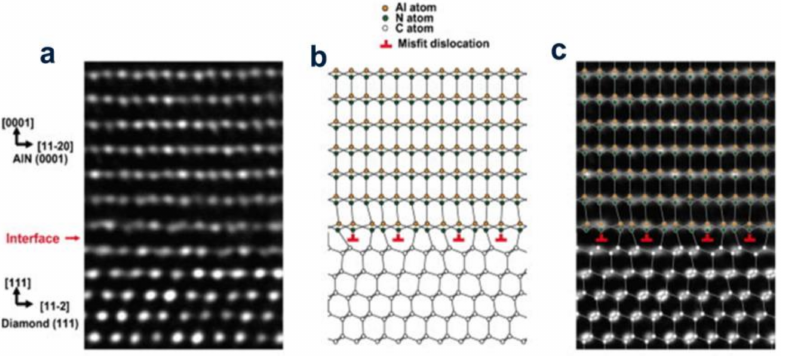
Figure 3. (Color online) ( a ) HR-TEM graphics of the AlN (0001)/diamond (111) heterogeneous contact surface. The small pointer displays the AlN/diamond contact surface. ( b ) Atomic distribution model obtained from the HR–TEM graphics. ( c ) is formed by ( a , b